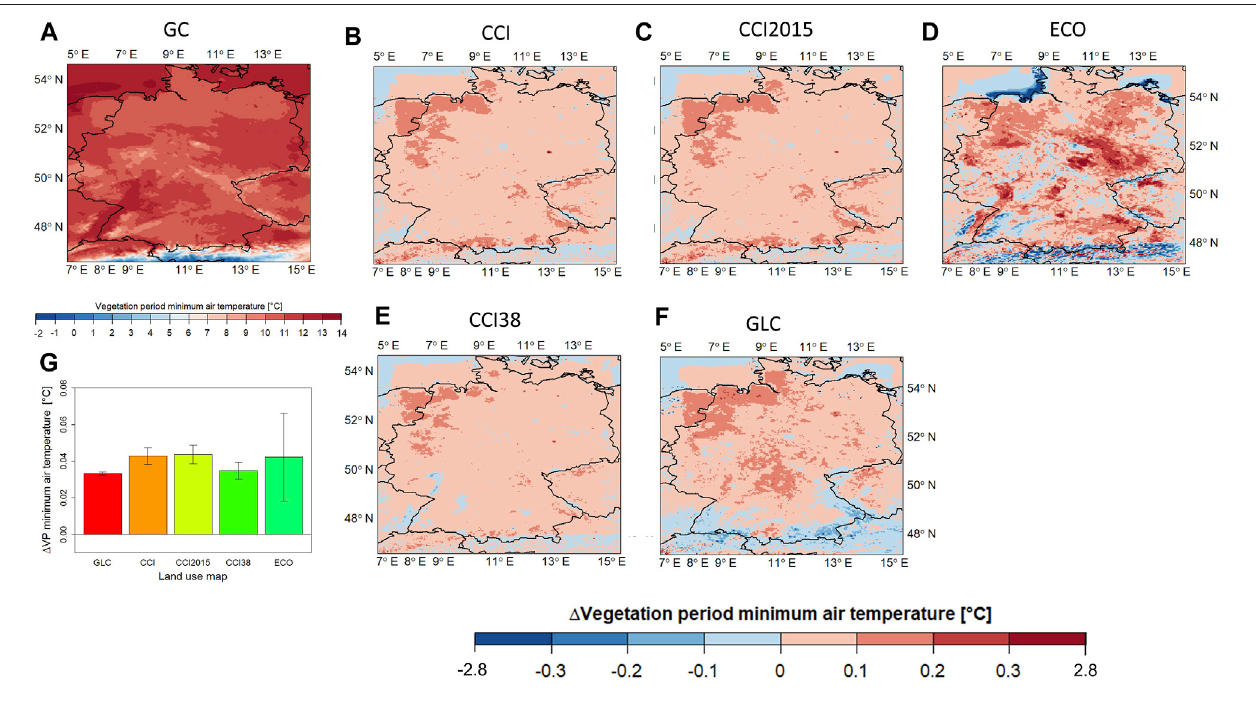
FIGURE 9 | Distribution of daily vegetation period minimum temperature climatology (2002 – 2011) for the control simulation based on GlobCover 2009 (A) , the difference between the simulation based on CCI and the control simulation (B) , the difference between the simulation based on CCI2015 and the control simulation (C) , thedifferencebetweenthesimulationbasedonECOandthecontrolsimulation (D) ,thedifferencebetweenthesimulationbasedonCCI38andthecontrolsimulation (E) , and the difference between the simulation based on GLC2000 and the control simulation (F) . Domain averaged differences in vegetation period minimum temperature for GLC, CCI, CCI 2015, CCI38, and ECO compared with the control simulation between 2002 and 2011 (G) . Please see Table 1 for abbreviations. Grids with an overlaid black circle indicate statistically signi fi cant (at the 95th percentile level using the t -test) differences.